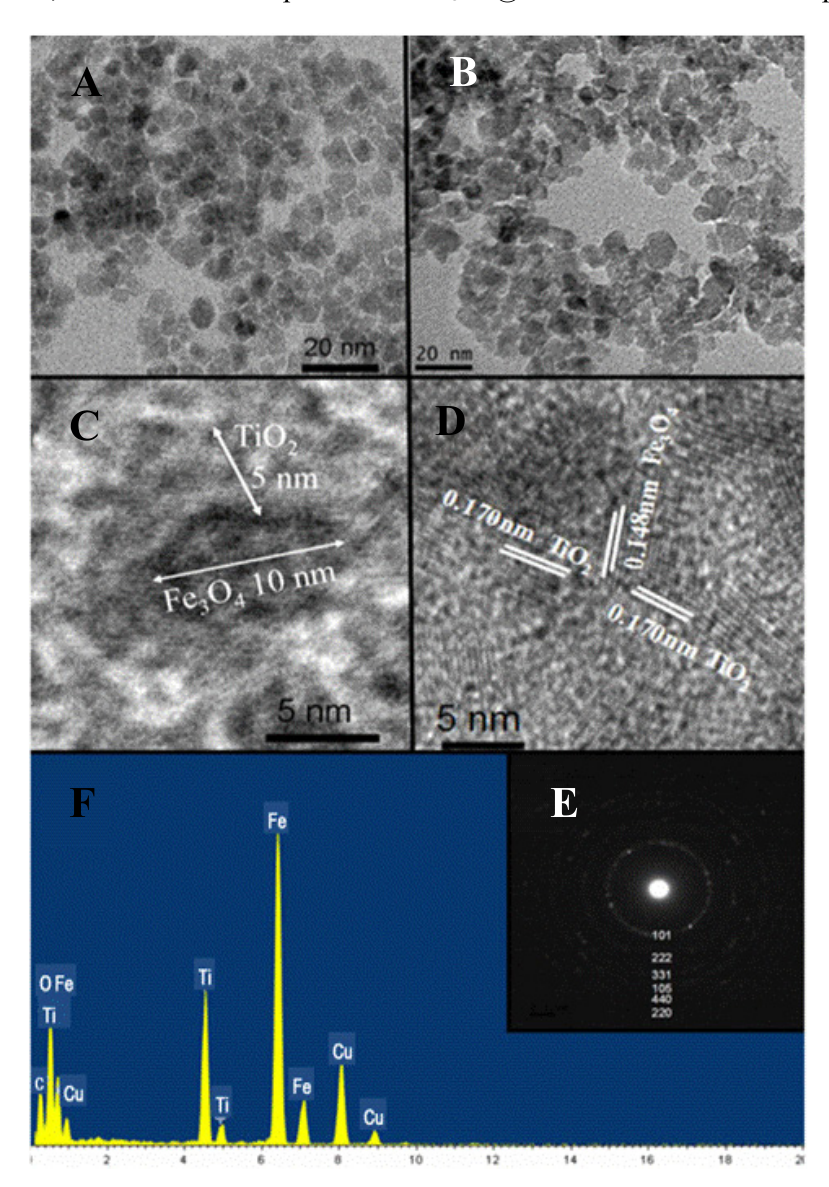
core-shell nanocomposites synthesized by solvothermal crystallization